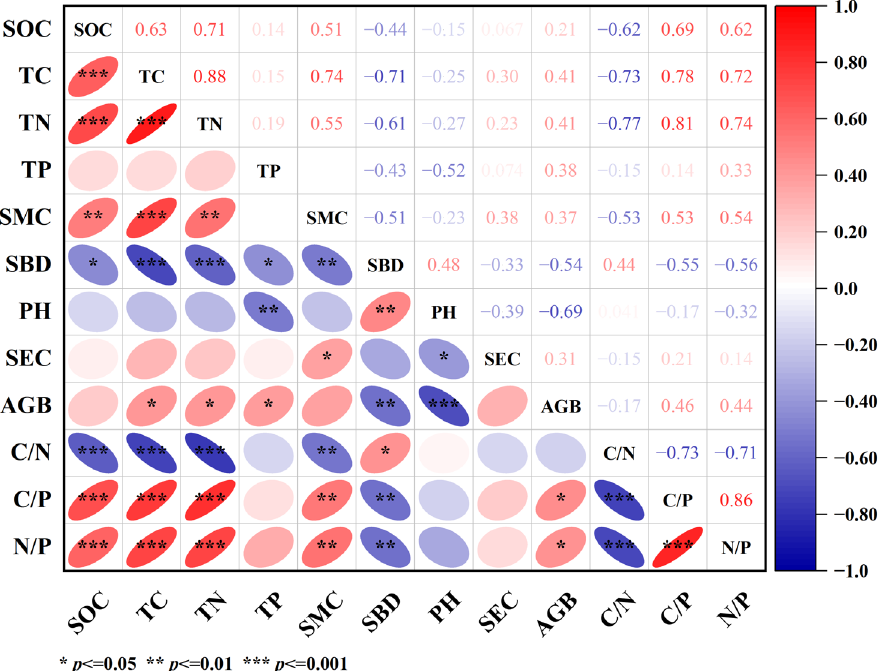
Figure 7. Correlation of soil properties with soil C, N and P contents and their biogenic stoichiometric characteristics.